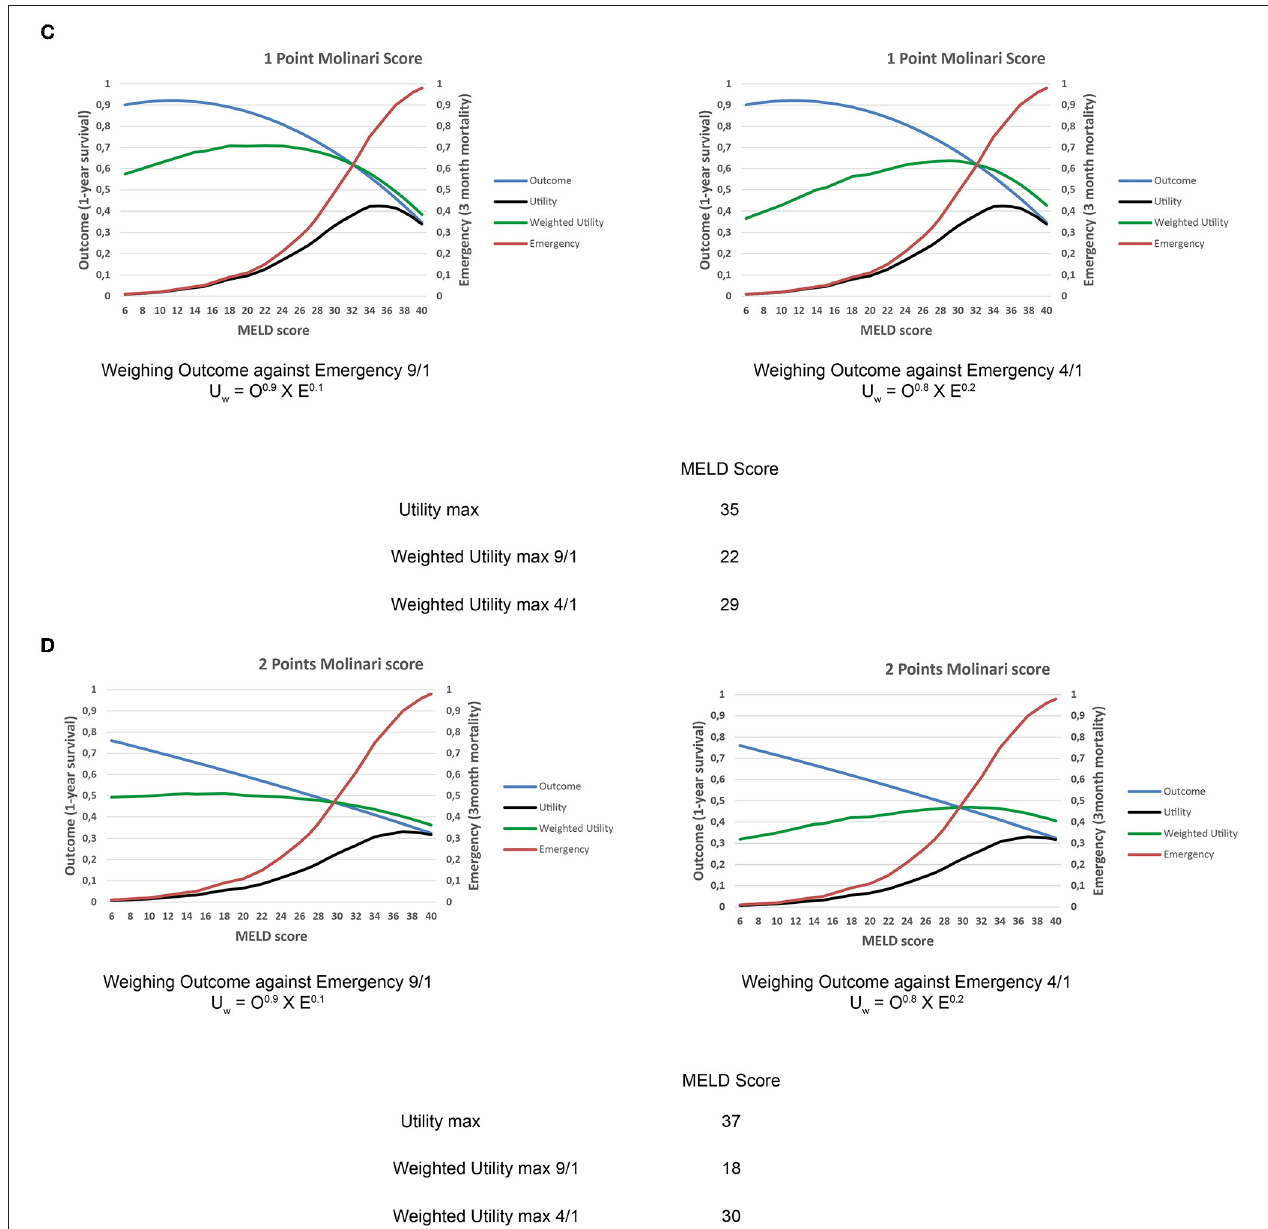
FIGURE 3 | (A) Weighted utility curves for all liver LT patients based on outcome [1-year survival after liver transplantation (LT) determined for every single Model for End-Stage Liver Disease (MELD) score value] and emergency (calculated 3-month mortality without LT upon MELD score) with a weighing of the outcome against emergency 9:1 and 4:1, respectively. The peak cuspidal point of the weighted utility curve represents the MELD zone of the highest utility. (B) Weighted utility curves for low-risk recipients (0 Molinari points) based on outcome [1-year survival after liver transplantation (LT) determined for every single Model for End-Stage Liver Disease (MELD) score value] and emergency (calculated 3-month mortality without LT upon MELD score) with a weighing of the outcome against emergency 9:1 and 4:1, respectively. The peak cuspidal point of the weighted utility curve represents the MELD zone of the highest utility. (C) Weighted utility curves for medium-risk recipients (1 Molinari point) based on outcome [1-year survival after liver transplantation (LT) determined for every single Model for End-Stage Liver Disease (MELD) score value] and emergency (calculated 3-month mortality without LT upon MELD score) with a weighing of the outcome against emergency 9:1 and 4:1, respectively. The peak cuspidal point of the weighted utility curve represents the MELD zone of the highest utility. (D) Weighted utility curves for high-risk recipients (2 Molinari points) based on outcome [1-year survival after liver transplantation (LT) determined for every single Model for End-Stage Liver Disease (MELD) score value] and emergency (calculated 3-month mortality without LT upon MELD score) with a weighing of the outcome against emergency 9:1 and 4:1, respectively. The peak cuspidal point of the weighted utility curve represents the MELD zone of the highest utility.